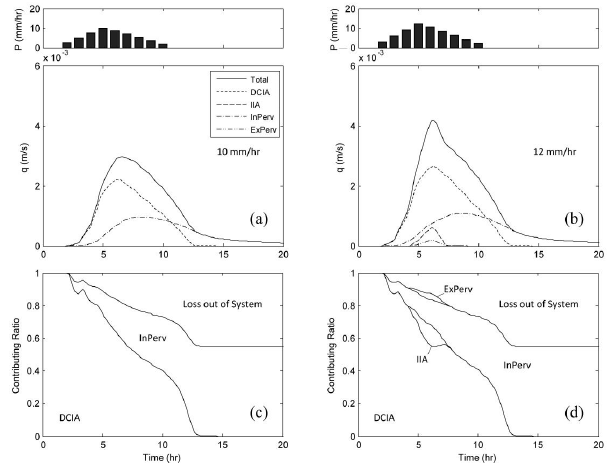
Figure 9 Flow discharge per unit area in CDS-51 with a triangular hyetograph and maximum 2 Fig. 9. Flow discharge per unit area in CDS-51 with a trian- intensity of (a) I = 10 mm/hr; (b) I = 12 mm/hr and the contributing ratio of each area with (c) 3 gular hyetograph and maximum intensity of (a) I = 10mmh − 1 , (b) I = 12mmh − 1 and the contributing ratio of each area with I = 10 mm/hr; (d) I = 12 m/hr 4 (c) I = 10mmh − 1 , (d) I = 12mh − 1 .